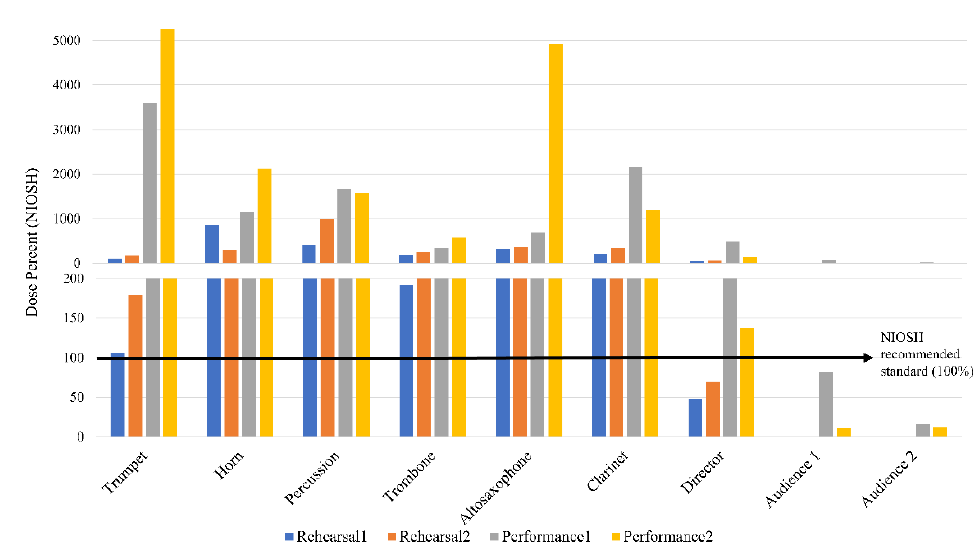
Figure 1. NIOSH noise doses during rehearsals and performances for participants as a function of instrument type. Table 1. Summarized data for noise dose, L Aeq range, and L TWA(8) of 6 marching band members and director during re- hearsals.